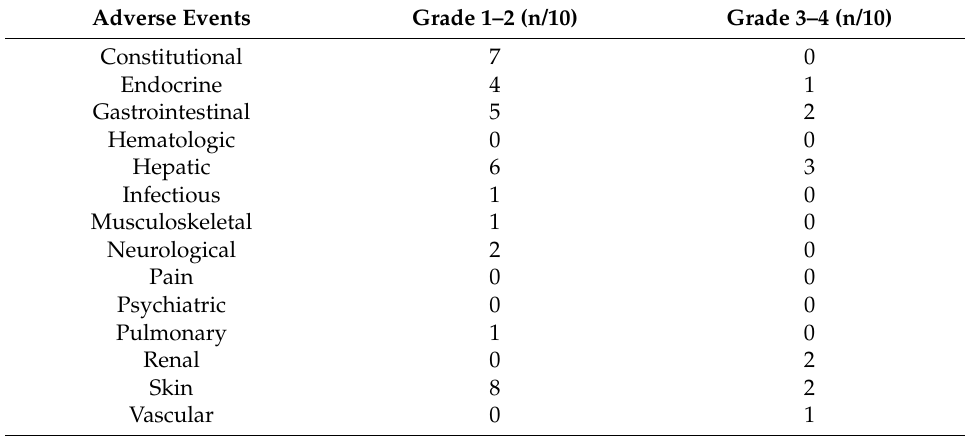
Table 2. Adverse Table 2. Adverse events.